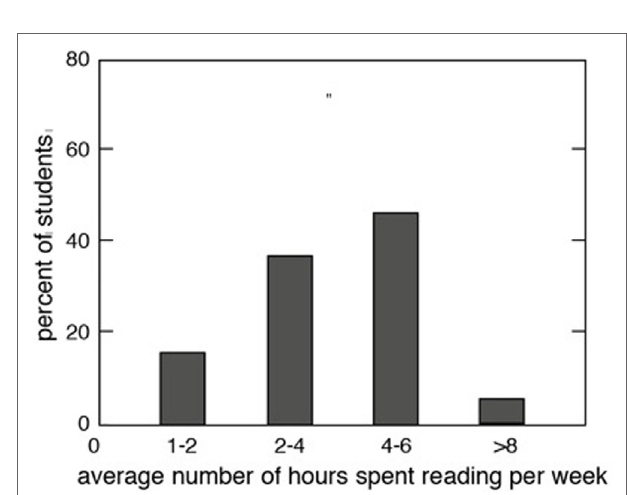
FigUre 11 | Histogram of the average number of hours students spend on the reading per week.